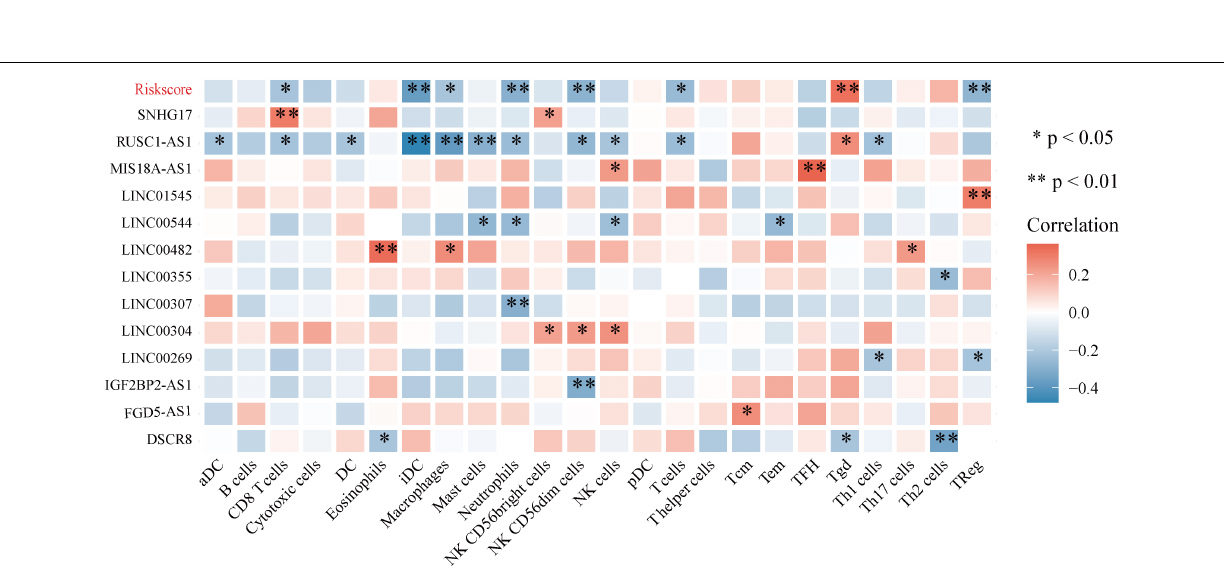
FIGURE 12 | Correlation between the 13 autophagy-related lncRNAs and immune cell